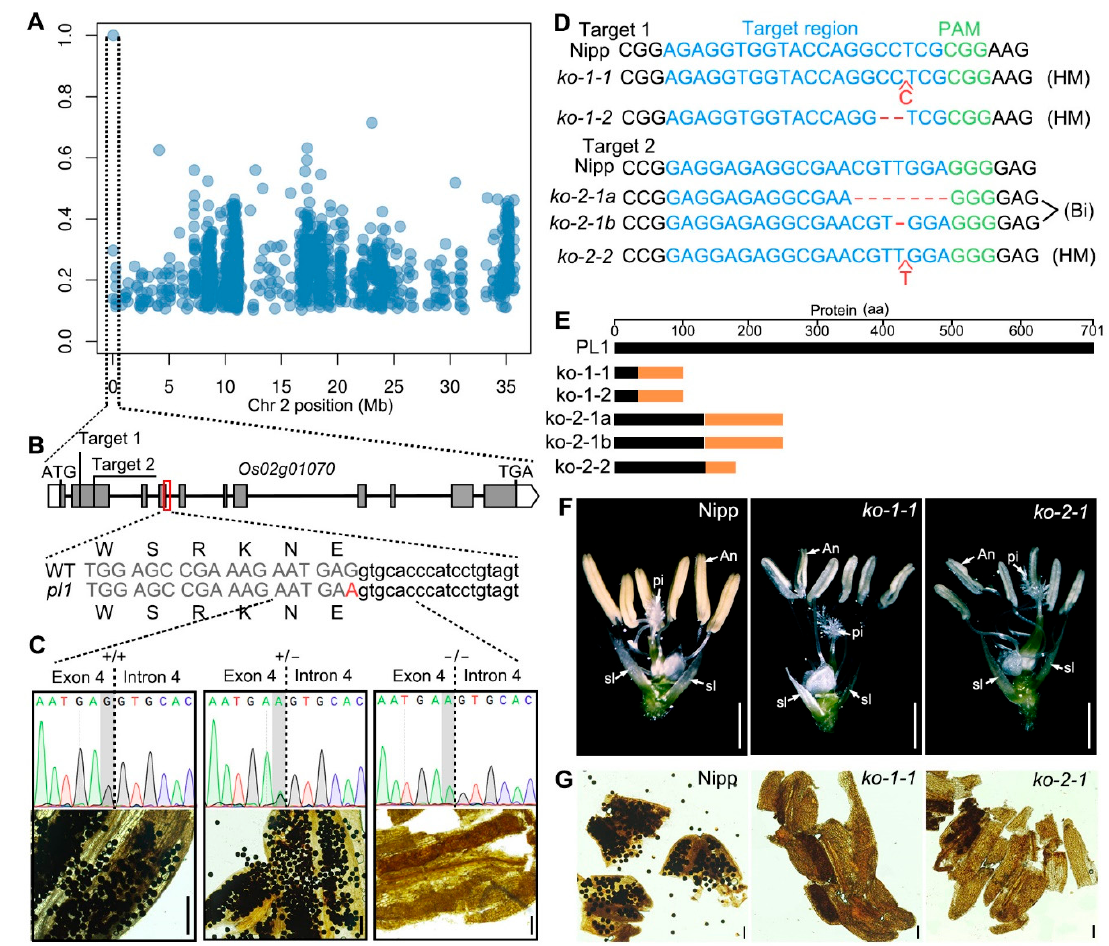
Figure 2. Cloning of PL1 gene. ( A ) SNPs Plot on chromosome 2 (Chr 2) identified by MutMap analysis. ( B ) The gene structure of PL1 . Genomic sequences around the mutated position of WT and pl1 and two independent CRISPR/Cas9 target sites are shown. Grey boxes indicate exons. Intervening lines indicate introns. White boxes indicate untranslated regions. Parts of sequences of exon 4 and intron 4 are shown in upper case (grey) and lower case (black), respectively. The pl1 mutation is highlighted with red color. ( C ) Genotypic and phenotypic identification of plants in F 2 population. The mutated position is highlighted with a grey background. ( D ) Genomic sequencing of the CRISPR/Cas9 target regions in Nipponbare (Nipp) and knock-out ( ko ) lines. Bi, biallelic mutation. ( E ) Schematic diagrams of the amino acid changes of PL1 in ko lines. Unchanged and changed amino acids are shown in black and orange color, respectively. aa, amino acids. ( F ) Spikelet of Nipp and ko lines after removing of the lemma and palea. An, anther; pi, pistil; sl, sterile lemma. ( G ) I 2 -KI staining of pollen grains of Nipp and ko lines at maturing stage. Bars = 100 μ m in ( C ) and ( G ), and 1 mm in ( F ).